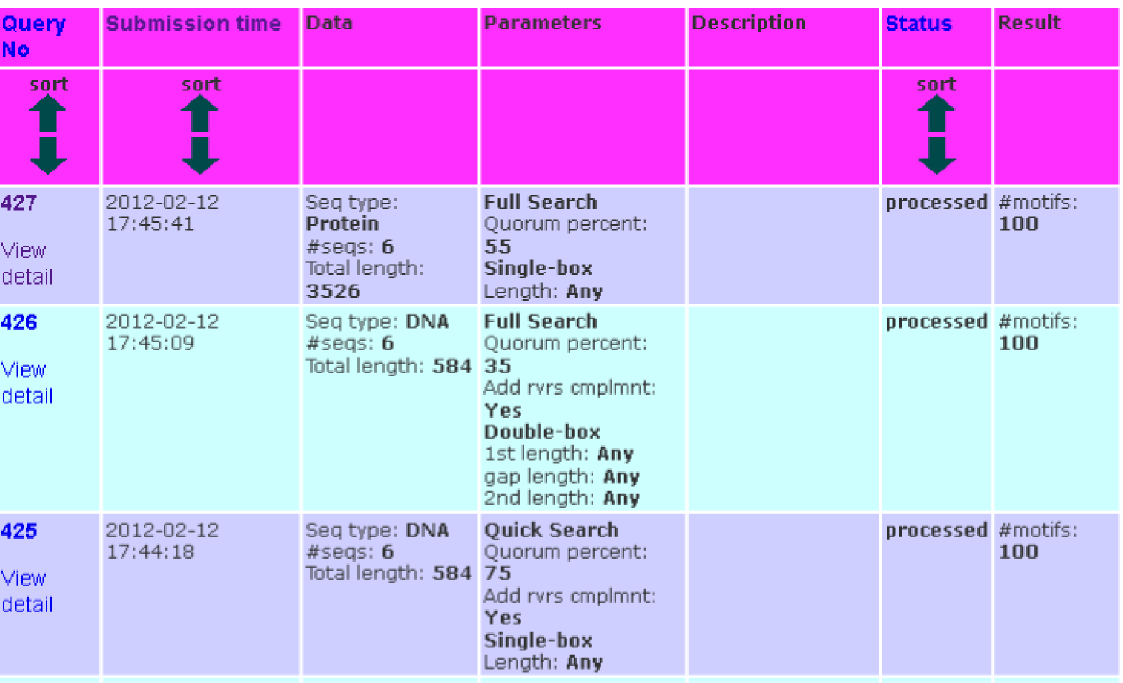
Figure 6. Submission history. An example of the submissions history. Users can sort their submissions based on query ID, submission time, or processing status. Users can view a particular submission in detail by clicking on the link ‘‘View detail’’ of the according submission.